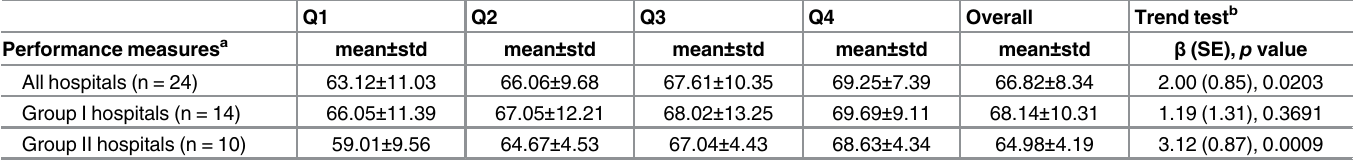
Table 4. Quarterly Composite Performance Measures of 24 Hospitals Participating in